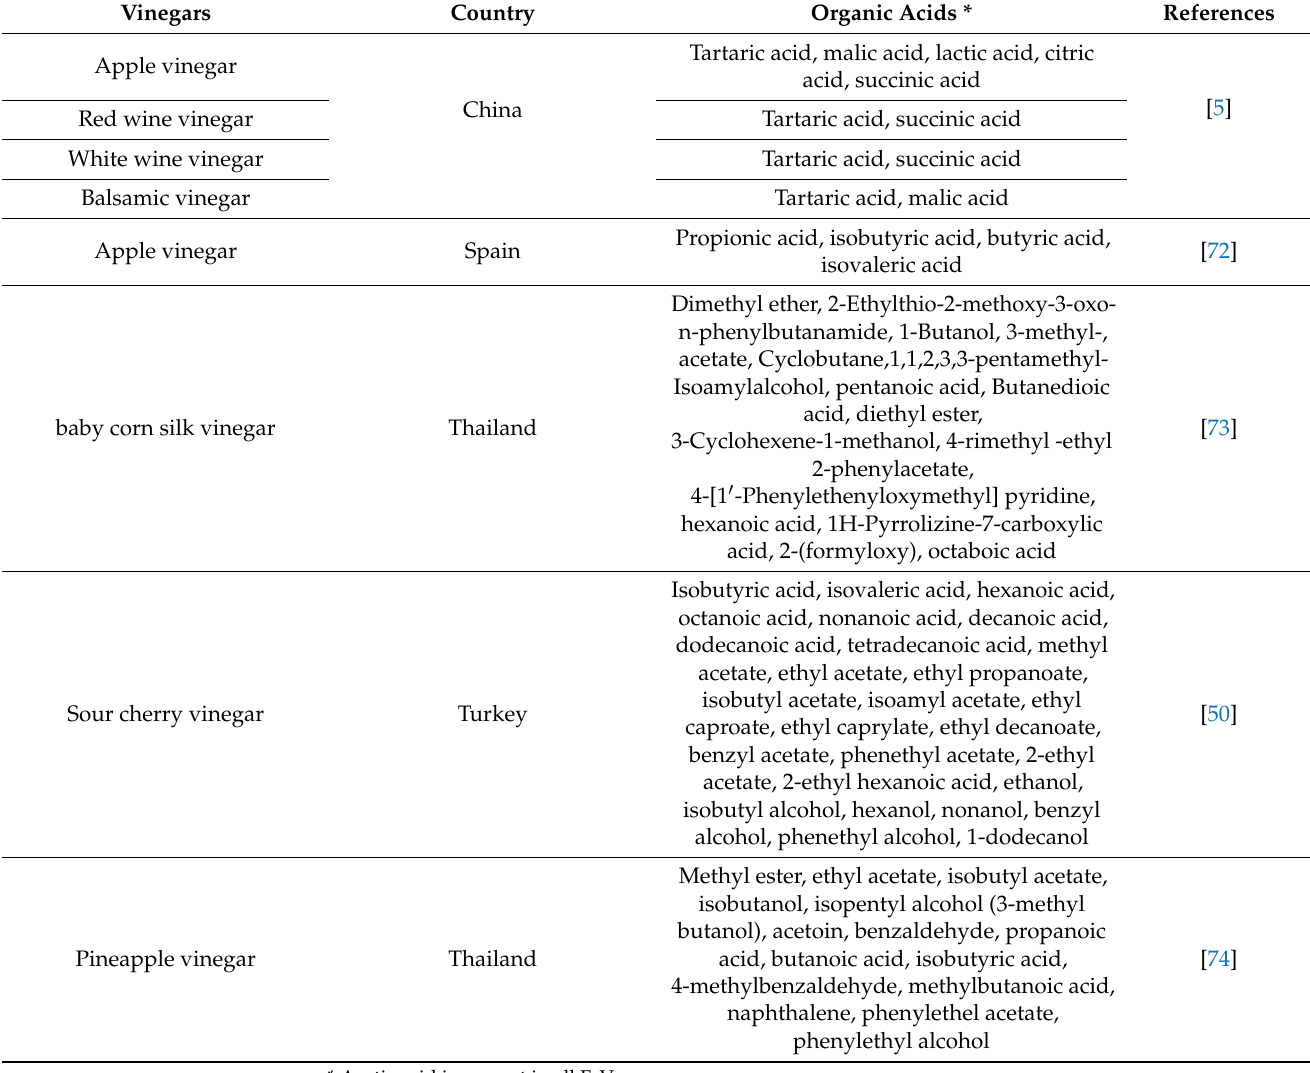
Table 3. Organic acids in